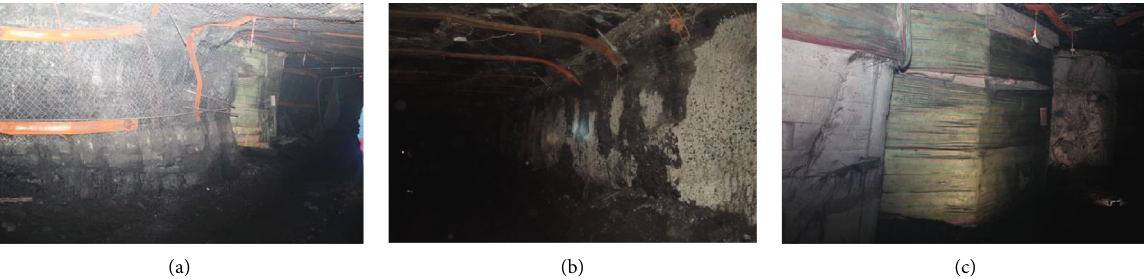
Figure 14: Exposure of the filling body at different backfill mining stages. (a) One-step mining. (b) Two-step mining. (c) Full mining and full backfilling.